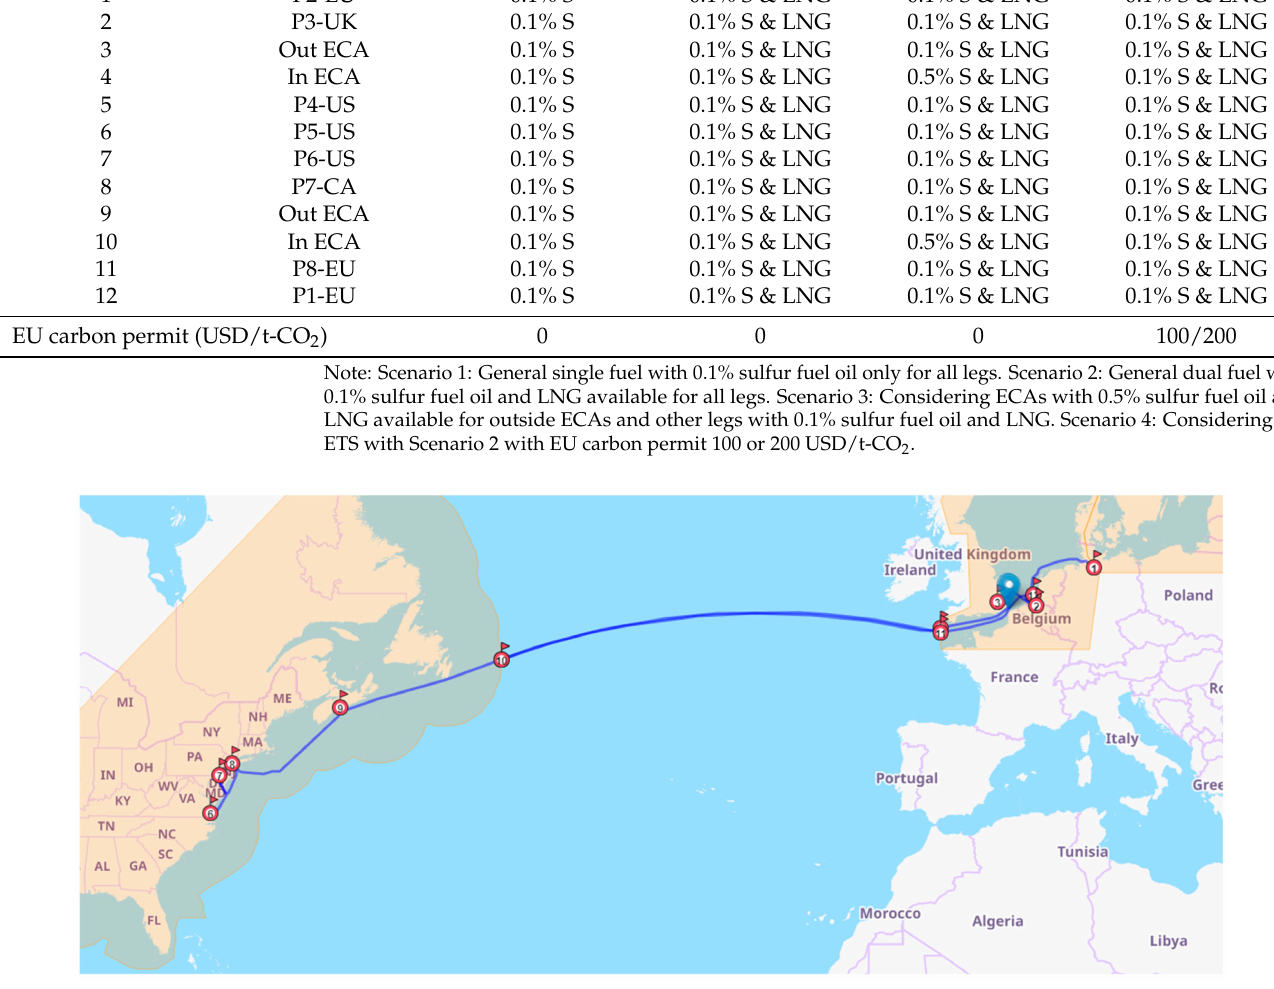
Figure 5. Map of the considered route. Orange regions were considered